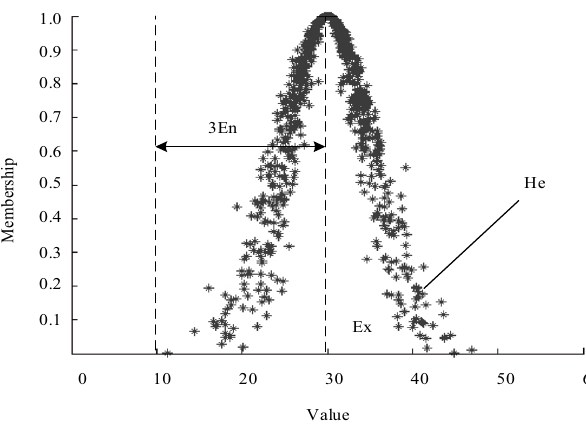
Figure 3. Schematic illustration of the digital features of the